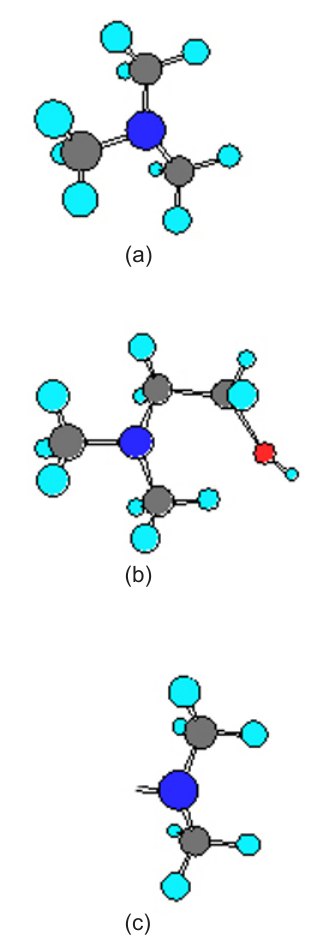
The structure of functional groups microporous anion exchangers Lewatit MonoPlus M 500 (a), Lewatit MonoPlus M 600 (b) and Lewatit MP 62 (c) (where colour blue denotes N atom, grey – C, red – O, cyan –